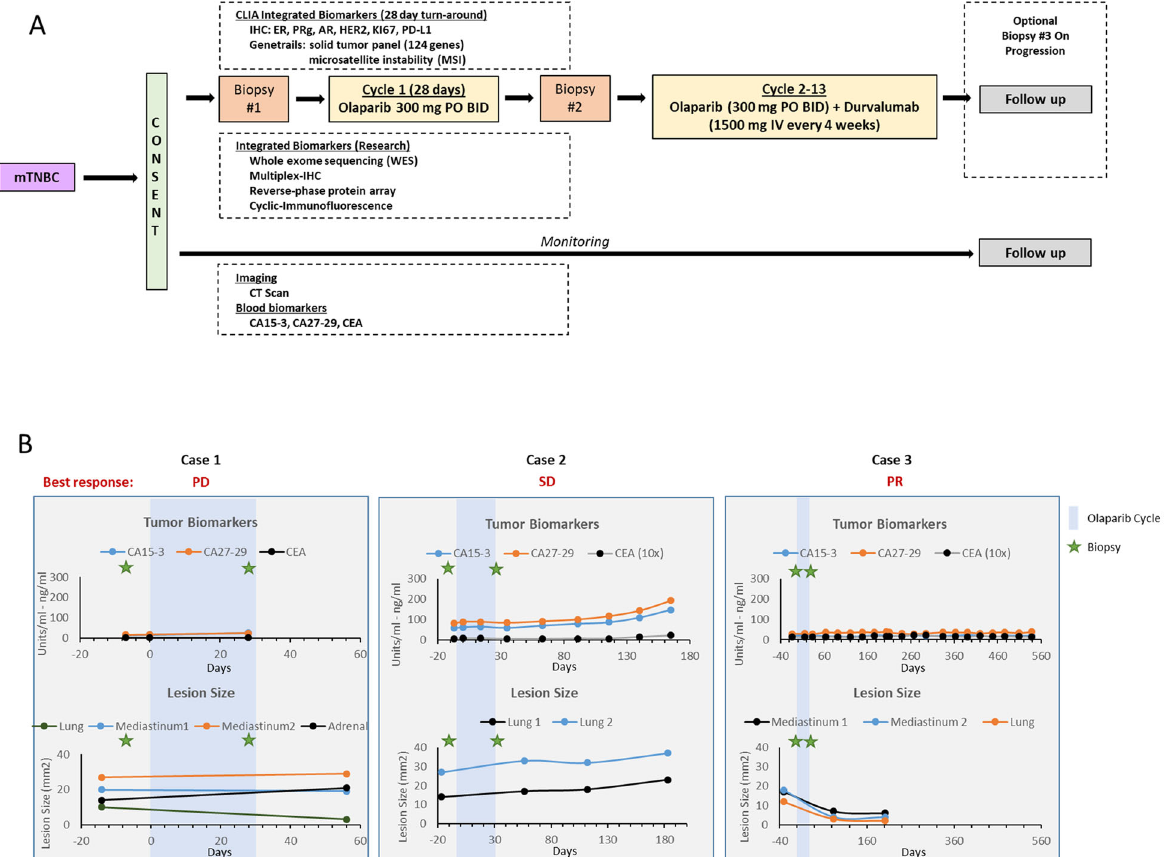
Fig. 1 Schematic of study design and patient ’ s response to olaparib and durvalumab combination. a After consent, mTNBC patients were subjected to a pre-treatment biopsy (#1) followed by one cycle of olaparib (28 days) and an on-treatment biopsy (#2). Patents were then treated with a combination of olaparib and durvalumab for up to 12 additional cycles. b (Upper panel) Blood biomarkers, (lower) lesion size. Green stars represent the time of pre and on-treatment biopsies collection and the blue bar represent the fi rst cycle of olaparib monotherapy, which started on day